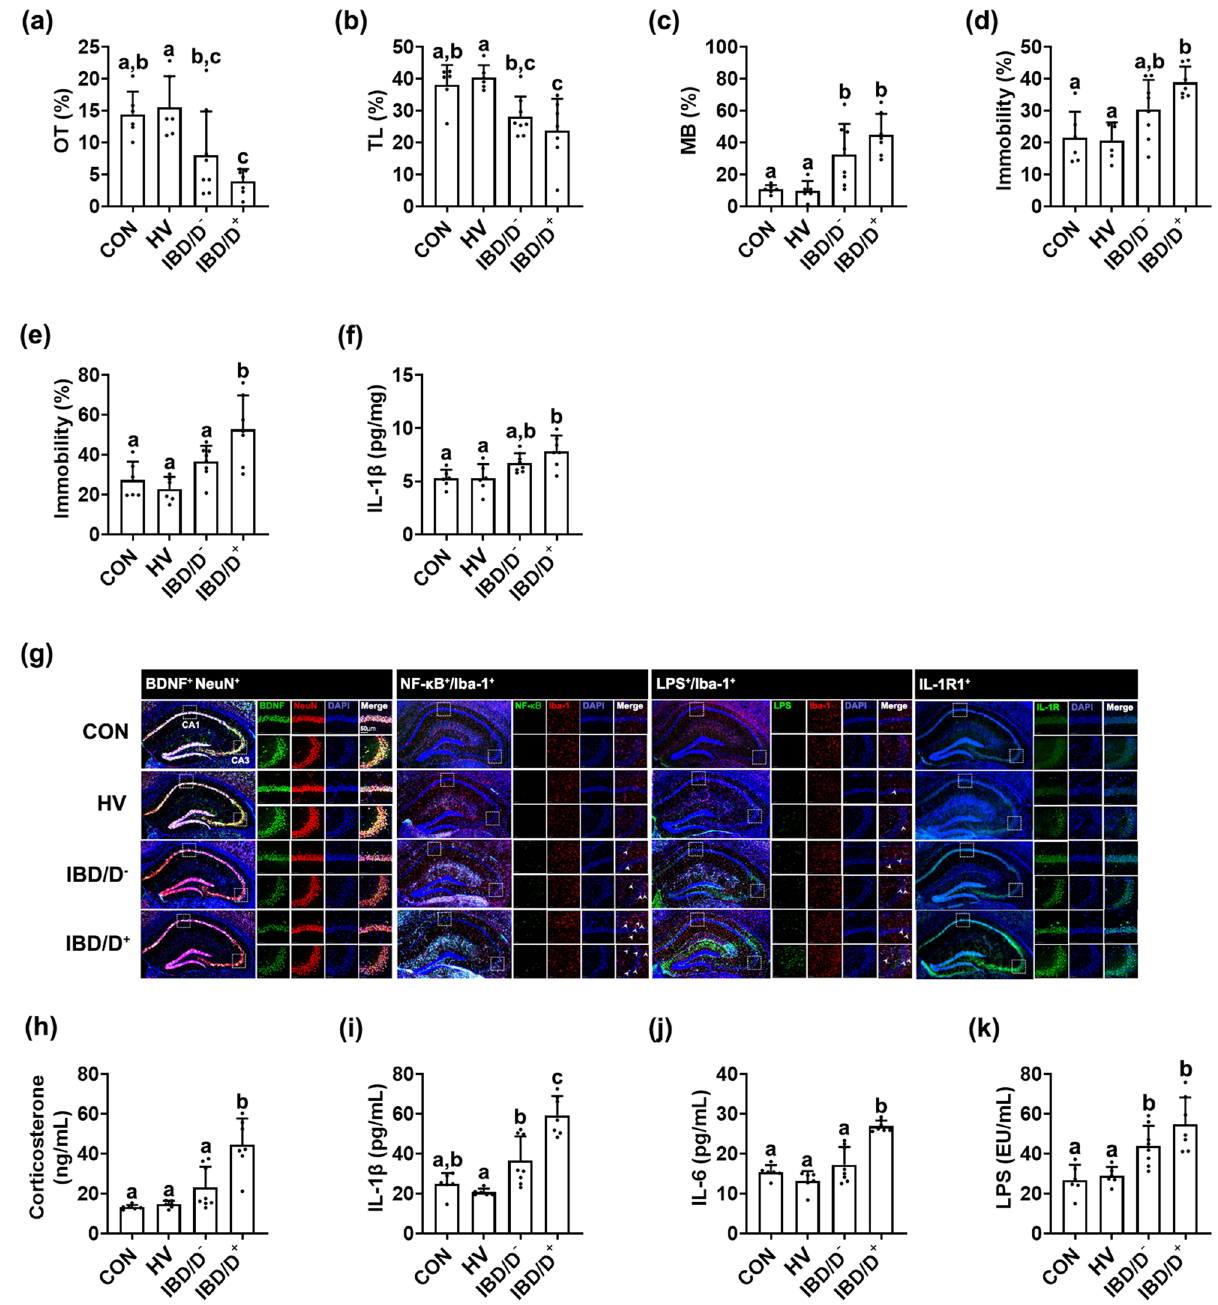
Figure 2. Fecal microbiota transplantation from patients with IBD/D − or IBD/D + and healthy volunteers (HVs) caused anxiety/depression in the transplanted mice. Effects on the occurrence of anxiety/depression in the EPM ( a ), LDT ( b ), MB tasks ( c ), TST ( d ), and FST ( e ). Effects on the IL-1β expression ( f ), BDNF + /NeuN + , NF-κB + / Iba1 + , LPS + /Iba1 + and IL-1R + cell populations in the hippocampus ( g ). Effects on the corticosterone ( h ), IL-1β ( i ), IL-6 ( j ), and LPS levels ( k ). Each HV-F (n = 6), IBD/D − -F (n = 8), or IBD/D + -F (n = 7) was orally transplanted in three mice once a day for 5 days. Control mice were treated with vehicle (saline) instead of fecal suspension. Data values were indicated as mean ± SD (NC n = 6; HV-F n = 6; IBD/D − n = 8; IBD/D + n = 7: each n value is the average obtained from 3 mice). Means with same letters are not significantly different ( p < 0.05). All data were analyzed using ANOVA with Tukey’s multiple comparisons